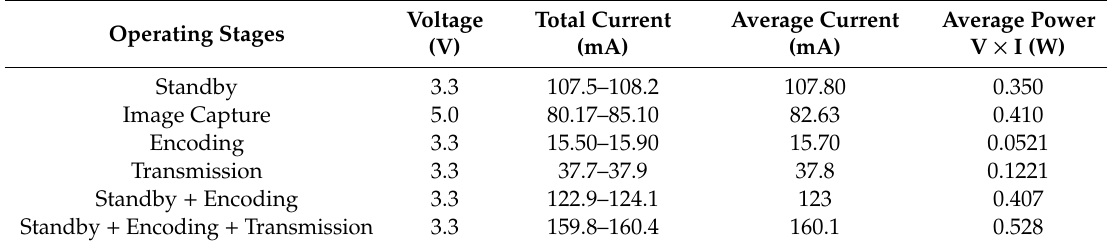
Table 2. Power consumed at di ff erent